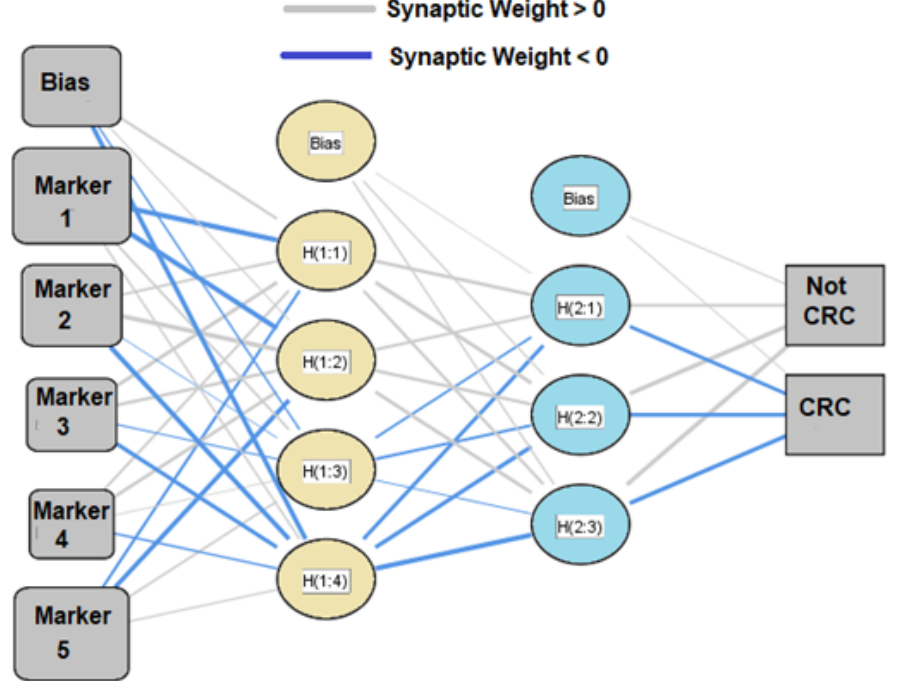
Figure 1. An illustrative example of an artificial neural network model consists of three layers: inputs, hidden, and output. The input represents raw information fed into the network.